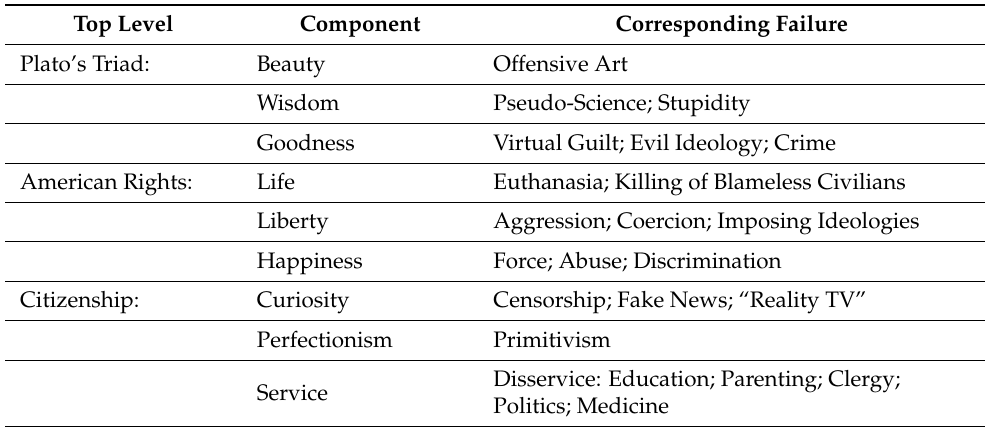
Table 1. Illustrating the example virtue code and associated failures.